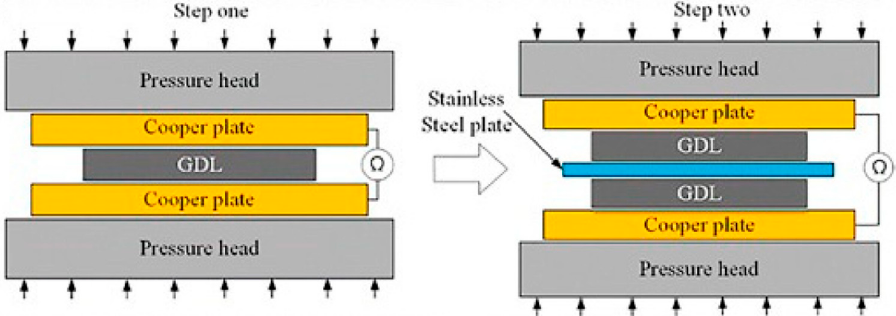
Figure 7. Principle of contact resistance measurement; stainless steel plate as a sample. Reprinted from [70] copyright (2018), with permission from Elsevier.